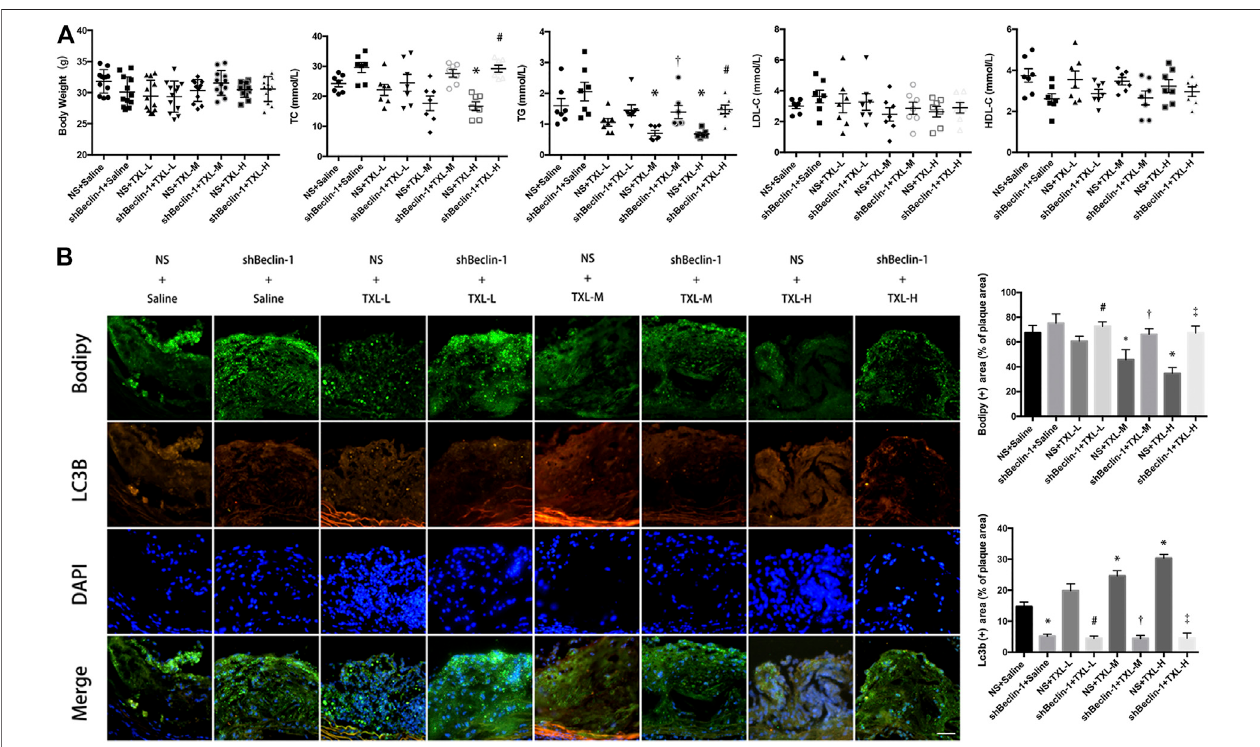
FIGURE1| TXLtreatment inhibited lipid deposition inadvanced atheroscleroticplaques. (A) Mouse body weight and blood lipids, n (cid:2) 7,* p < 0.05 vs. NS+Saline, # p < 0.05 vs. NS + TXL-H, † p < 0.05 vs. NS + TXL-M. (B) Effects of TXL on autophagy and lipid deposition in advanced atherosclerotic plaques, n (cid:2) 3, bar (cid:2) 50 μ m * p < 0.05 vs. NS + Saline, # p < 0.05 vs. NS + TXL-L, † p < 0.05 vs. NS + TXL-M, ‡ p < 0.05 vs. NS +